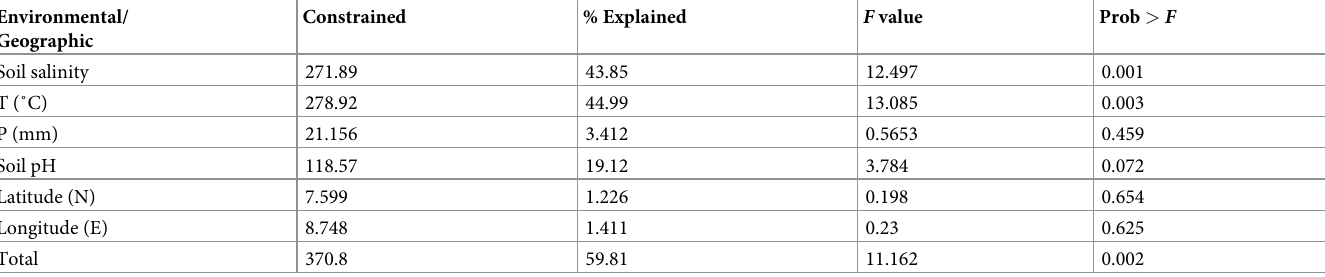
High levels of phenotypic variability among these genetically similar S . alterniflora popula- tions and no correlativity between phenotypic differences and genetic differentiation might provide evidence of phenotypic plasticity. Phenotypic variation of S . alterniflora in China due to phenotypic plasticity rather than genetic variation was also revealed in the study of Liu et al. by a common garden experiment [49]. Low genetic diversity with high phenotypic variability was also revealed in other species of Spartina , such as S . densiflora populations in North Amer- ica [50]. Therefore, in spite of genetic bottlenecks and low genetic diversity might be the nega- tive effects for invasive alien species spreading, high phenotypic plasticity may improve their responses to new environments [29, 51, 52]